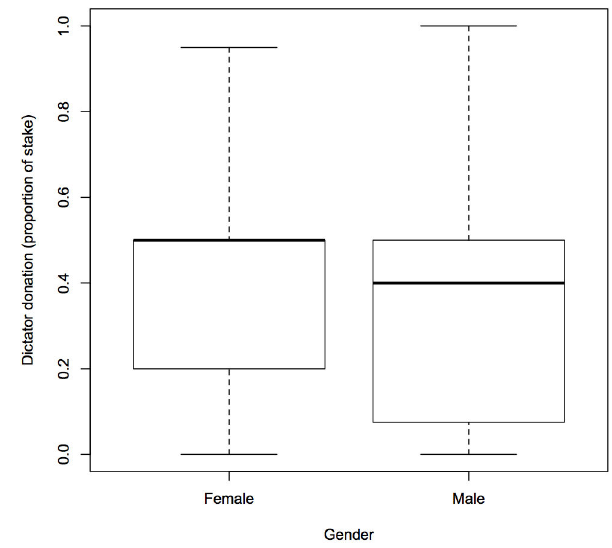
Figure 3. Boxplot of dictator donations (proportion of endowment given to receiver) according to gender for US players. Solid lines represent medians while the upper and lower boundaries of the box are the upper and lower quartiles of the data. The highest and lowest values in the data (excluding outliers) are indicated by the bars extending from the boxes.